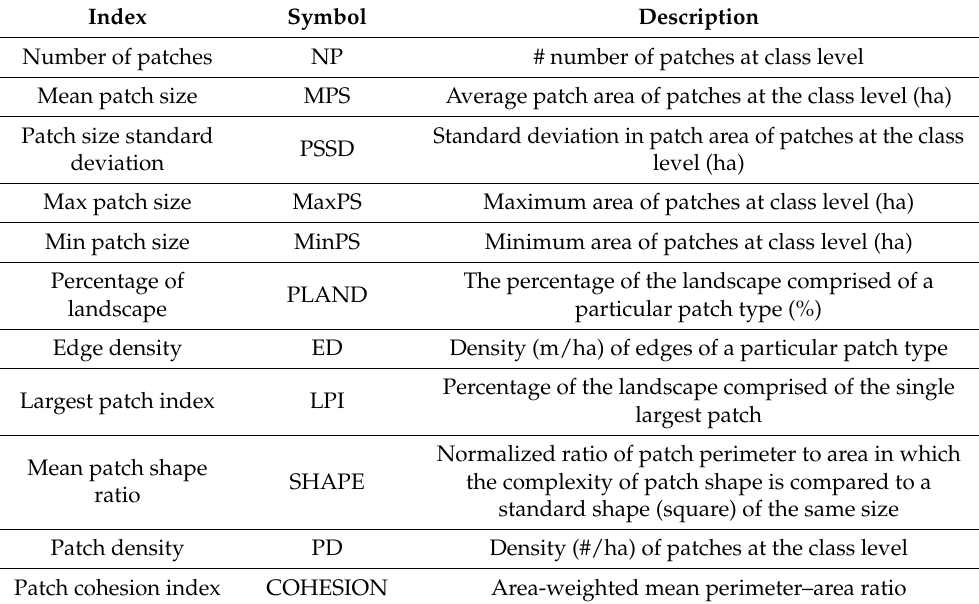
Table 1. List of the metrics selected for landscape analysis at the class level and their description.